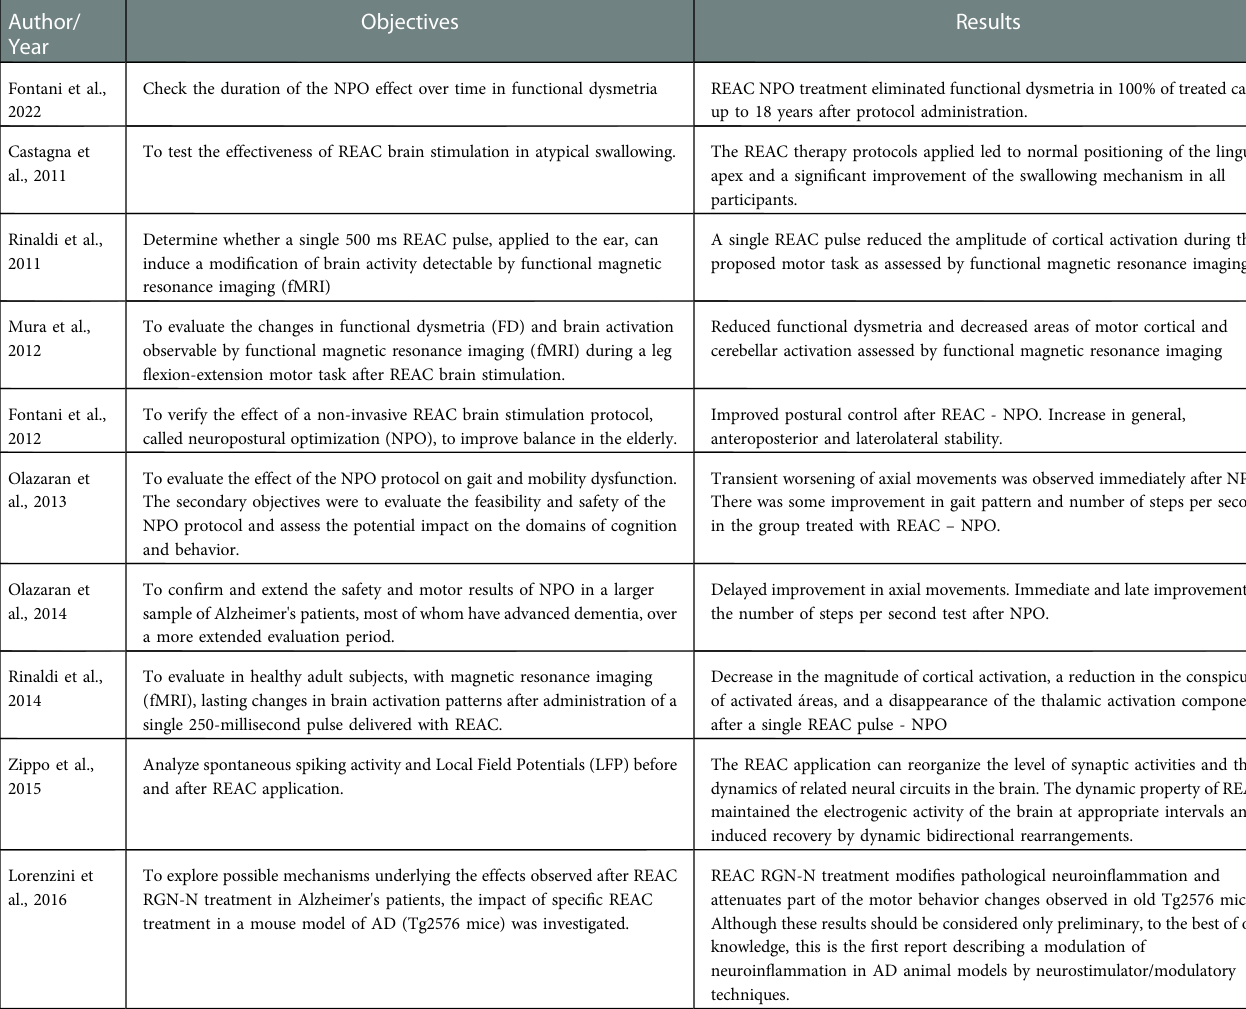
TABLE 2 Objectives and results of the clinical and experimental studies included in the